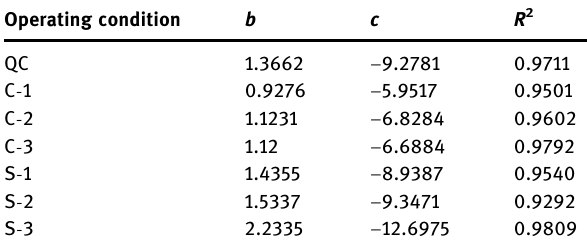
Table 9: Webb regression results of concrete life